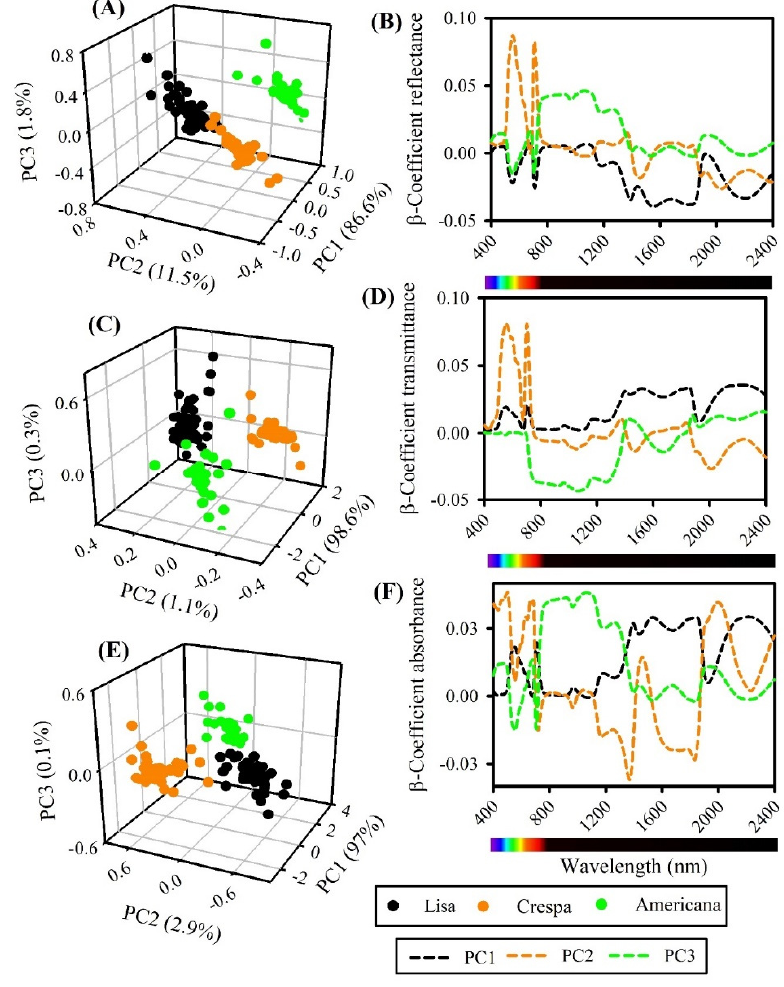
Figure 6. ( A ) Contribution of principal component analysis (PCA) and β -coefficients for hyperspec- tral data (400–2400 nm) of lettuce plants: ( A , B ) reflectance, ( C , D ) transmittance, ( E , F ) absorbance. ( A , C , E ) PC score 3D plots. ( B , D , F ) β -coefficients for reflectance, transmittance, and absorbance, re- spectively (n = 600).